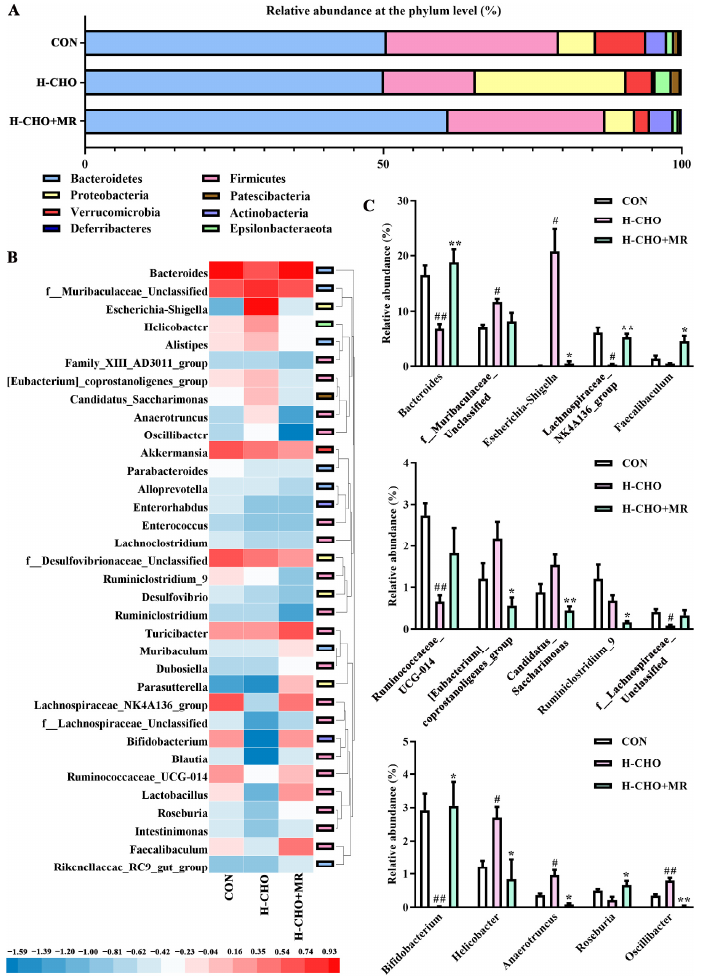
Figure 4. MR altered the gut microbiota composition in feces of mice fed with the H-CHO diet. ( A ) relative abundance of the major bacterial phyla in mouse feces; ( B ) heat map of the microbiota in mouse feces at the genus level (relative abundance > 0.2%); ( C ) comparison of relative abundance at the genus levels among the CON, H-CHO, and H-CHO+MR groups. MR, methionine restriction; CON, normal diet group; H-CHO, high-choline diet group; H-CHO+MR, high-choline + methionine restricted diet group. # p < 0.05, ## p < 0.01 (H-CHO vs. CON); * p < 0.05, ** p < 0.01 (H-CHO+MR vs. H-CHO).